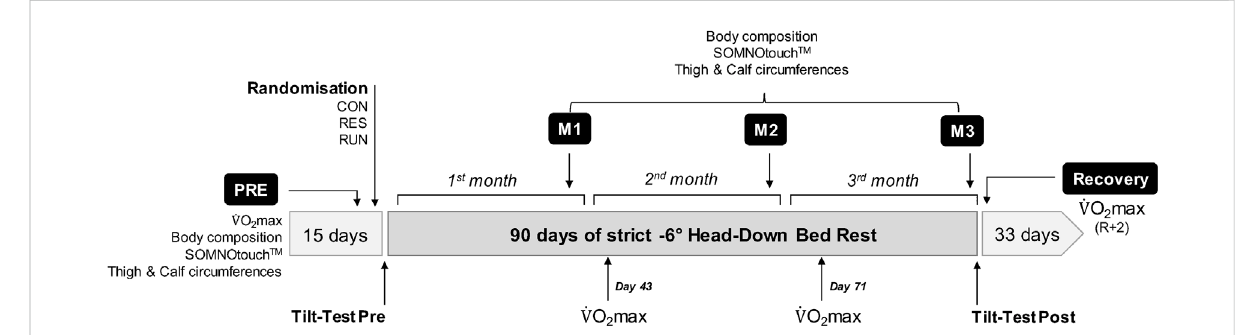
FIGURE 1 Studychronologywithperformedmeasurements.Theexperimentconsistedof15 daysofbaselinemeasurements(Pre),followedby90 daysof strict head-down bedrest where the subjects remained in a 6 ° head-down posture full time and 33 days of recovery (R + x